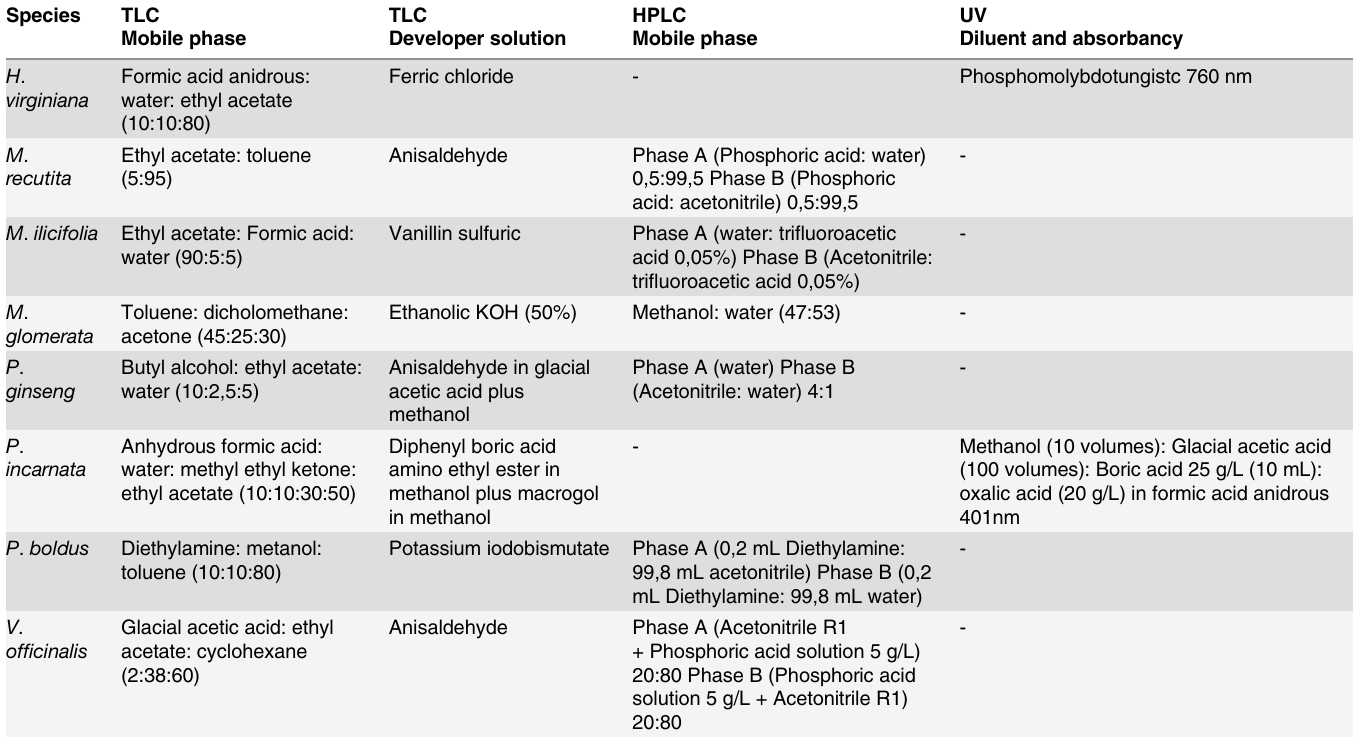
Table 2. Conditions used for the chemical